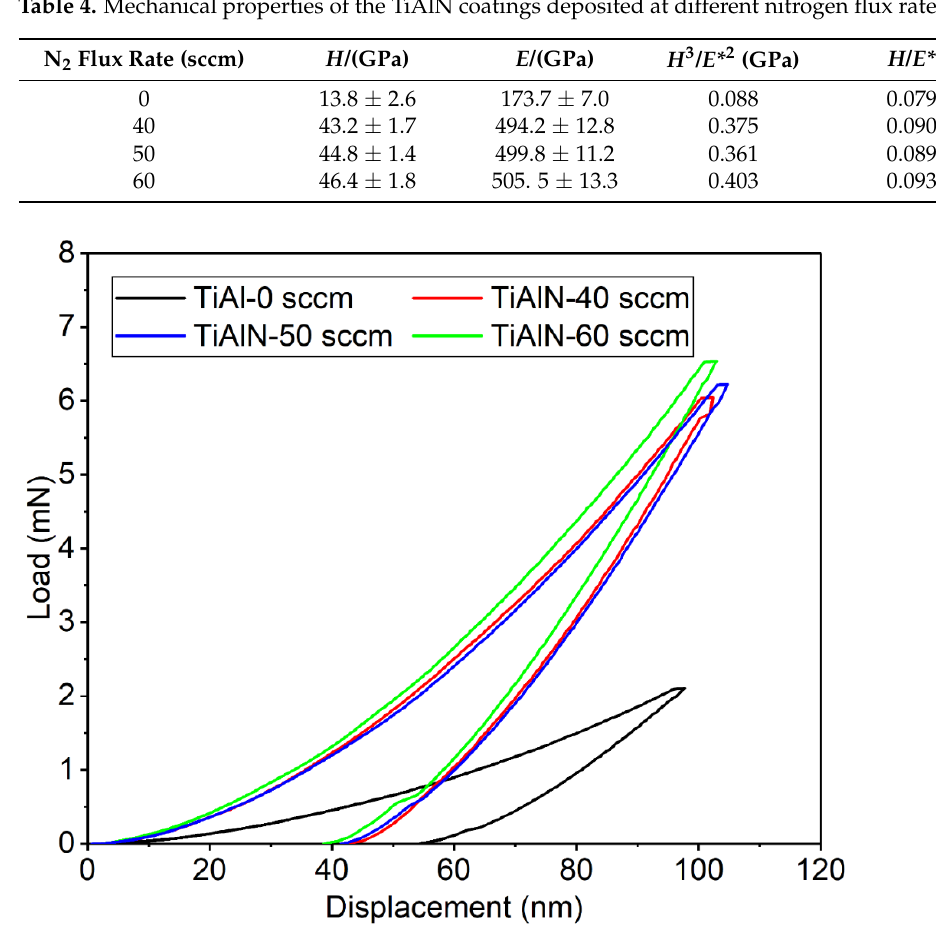
Figure 9. The loading – displacement curves for the TiAlN coatings deposited under different nitro- gen flux